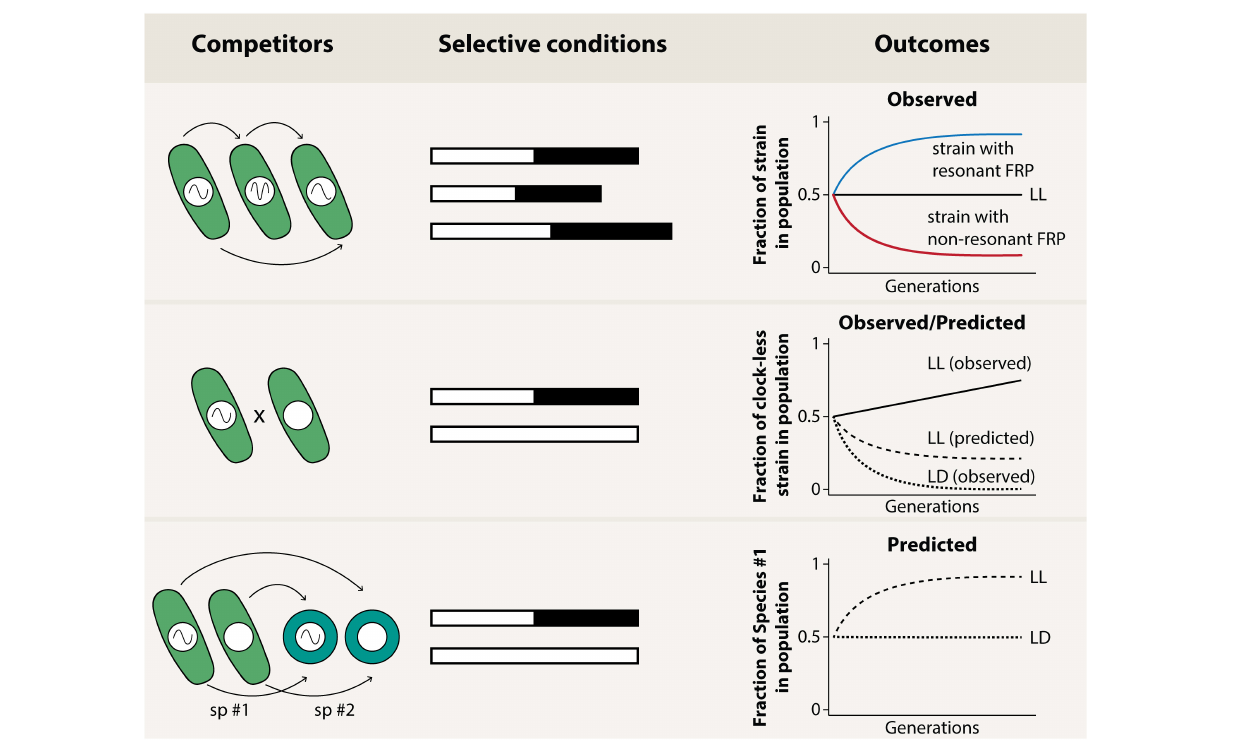
FIGURE 2 | Diagram showing the results of experiments done previously to test the adaptive value of the circadian clock in cyanobacteria (first and second row) , as well as a proposed experiment (third row) . Experiments in the first row refer to publications described in the text (Ouyang et al., 1998; Woelfle et al., 2004; Ma et al., 2013), and show that resonance between the circadian period (FRP = free-running period) and the environmental period increases cyanobacterial fitness, while no difference was observed in constant conditions (LL). Experiments in the second row are explained in more detail in the text (Woelfle et al., 2004; Ma et al., 2013), and show that cyanobacteria with circadian clocks outcompete clock-less cyanobacteria in rhythmic (LD) but not in constant (LL) conditions. This latter result was unexpected given the typical bias among chronobiologists that circadian clocks would be able to increase fitness by facilitating proper internal temporal order. The last row features an experiment that is yet to be reported, namely, interspecific competitions between different species of cyanobacteria. A possible prediction of this experiment is that the co-existence or not of the two species would be modulated by the environmental rhythmic conditions, and perhaps by the two species’ circadian